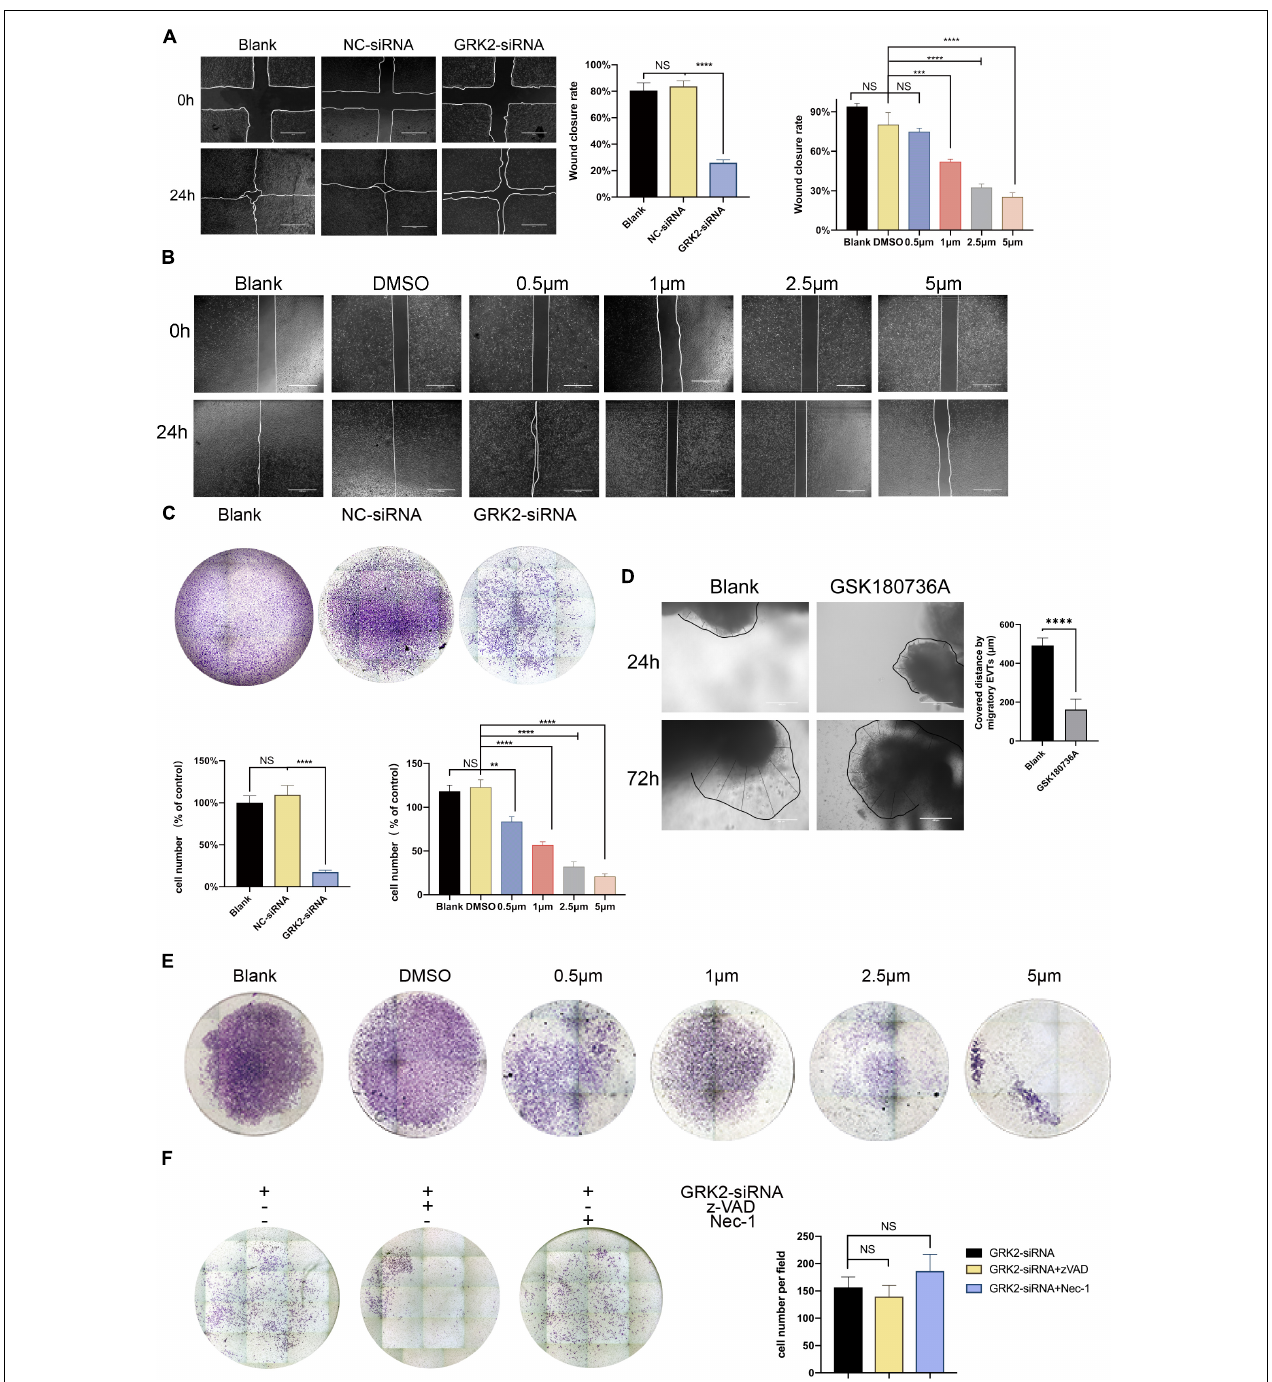
FIGURE 7 | Decreased GRK2 levels or activity undermines migration and invasion in HTR8/SVneo cells, after excluding dead cells. (A) Migration ability of HTR8/SVneo cells assessed by wound closure assay. After 24 h, the wound edges are nearly closed in blank and NC-siRNA groups, while that in GRK2-siRNA group remained apparent distances. While lines, wound edges. Scale bar, 100 µ M. (B) Migration ability tests on HTR8/SVneo cells with GSK180736A at different concentrations (0.5, 1, 2.5, and 5 µ M) for 24 h. Scale bar, 100 µ M. (C) Representative images of invaded HTR8/SVneo cells through chambers’ membrane (100 × ). The histograms show apparently reduced percentage of invasive cells in GRK2-siRNA group compared to others, which should be interpreted more than necroptosis. (D) Representative images and the analysis of EVTs migration ability tests performed on human villous explants. (E) Representative images of invaded through chambers’ membrane(x100). HTR8/SVneo cells treated with GSK180736A at different concentrations (0.5 µ M, 1 µ M, 2.5 µ M, 5 µ M) for 24 hrs and invaded through chambers’ membrane(100x). (F) HTR8/SVneo cells administrated with z-VAD-FMK (25 µ M, 24 hrs) or nec-1 (30 µ M, 24 hrs) cannot restore the migration ability of cells. Note: NS, not significant; **P <0.01, ***P <0.001, ****P <0.0001.